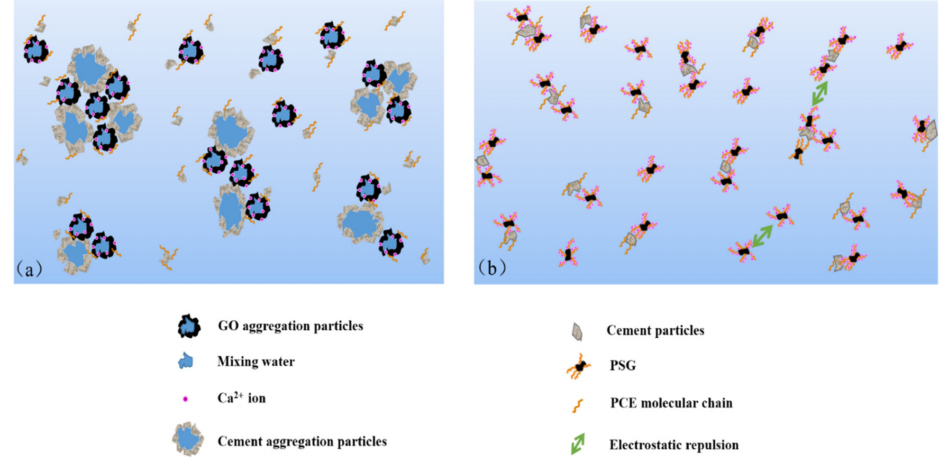
Figure 24. Schematic diagram of mechanism of GO and PSG on cement paste: ( a ) GO-cement system; and ( b ) PSG-cement